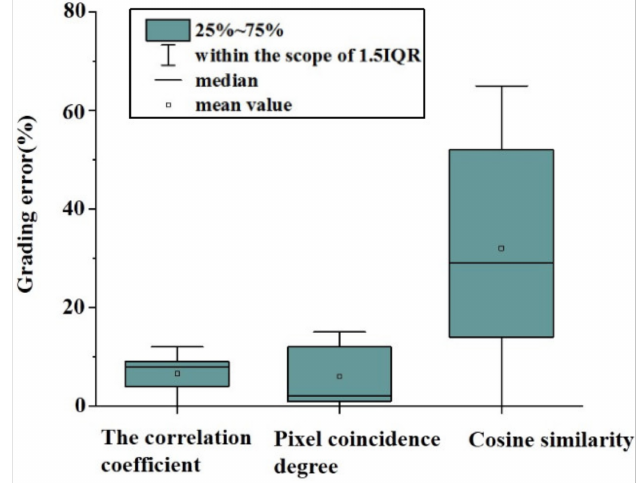
Figure 14. Statistical distributions of grading errors in similarity evaluation